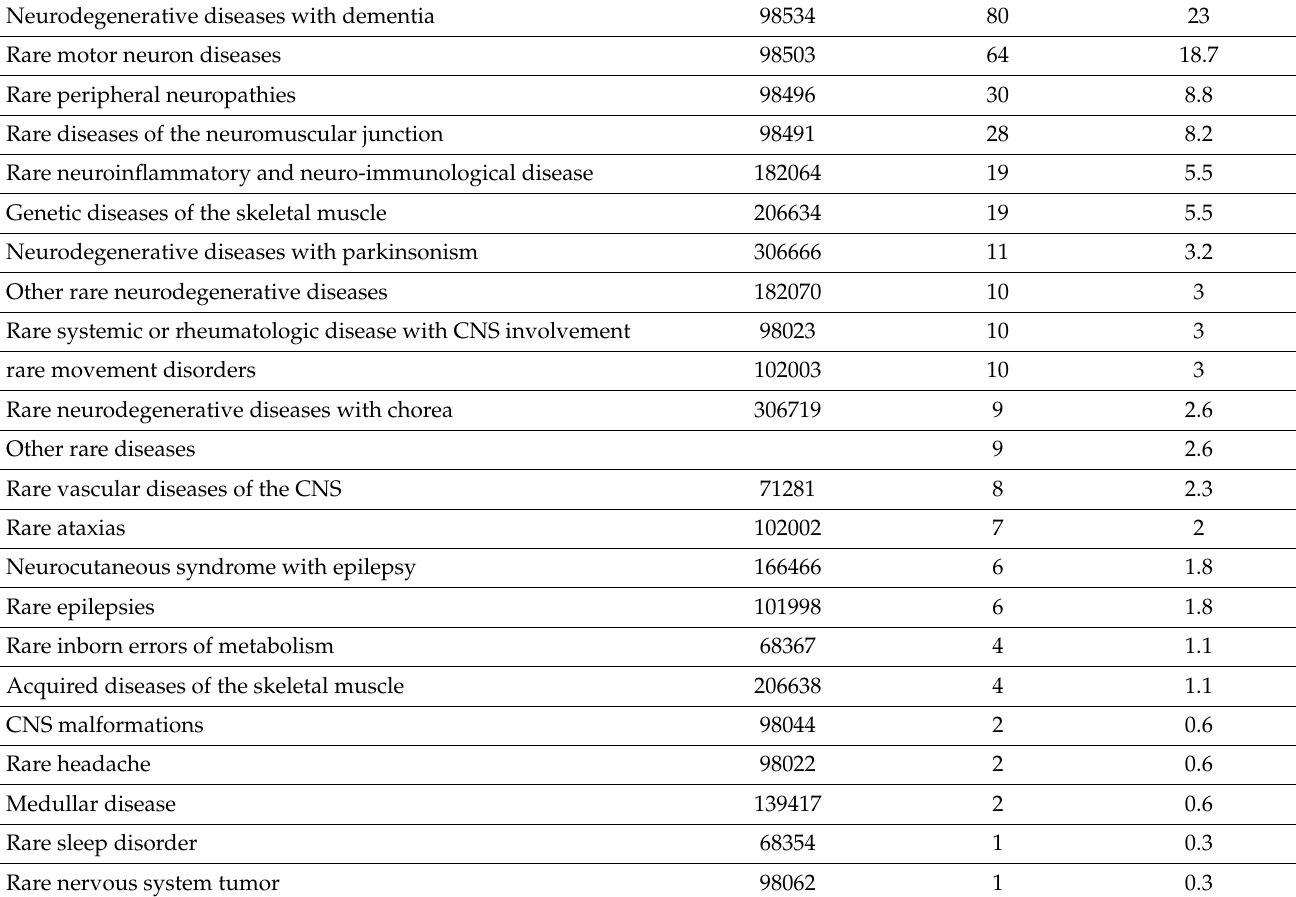
Table 1. Rare Neurological Diseases diagnosed and relevant ORPHAcode